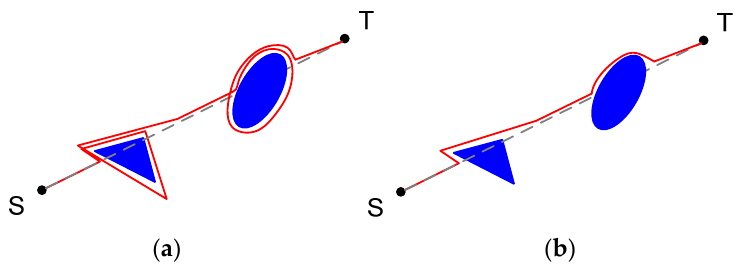
Figure 2. Bug-1 ( a ) and Bug-2 ( b ) algorithms comparison.